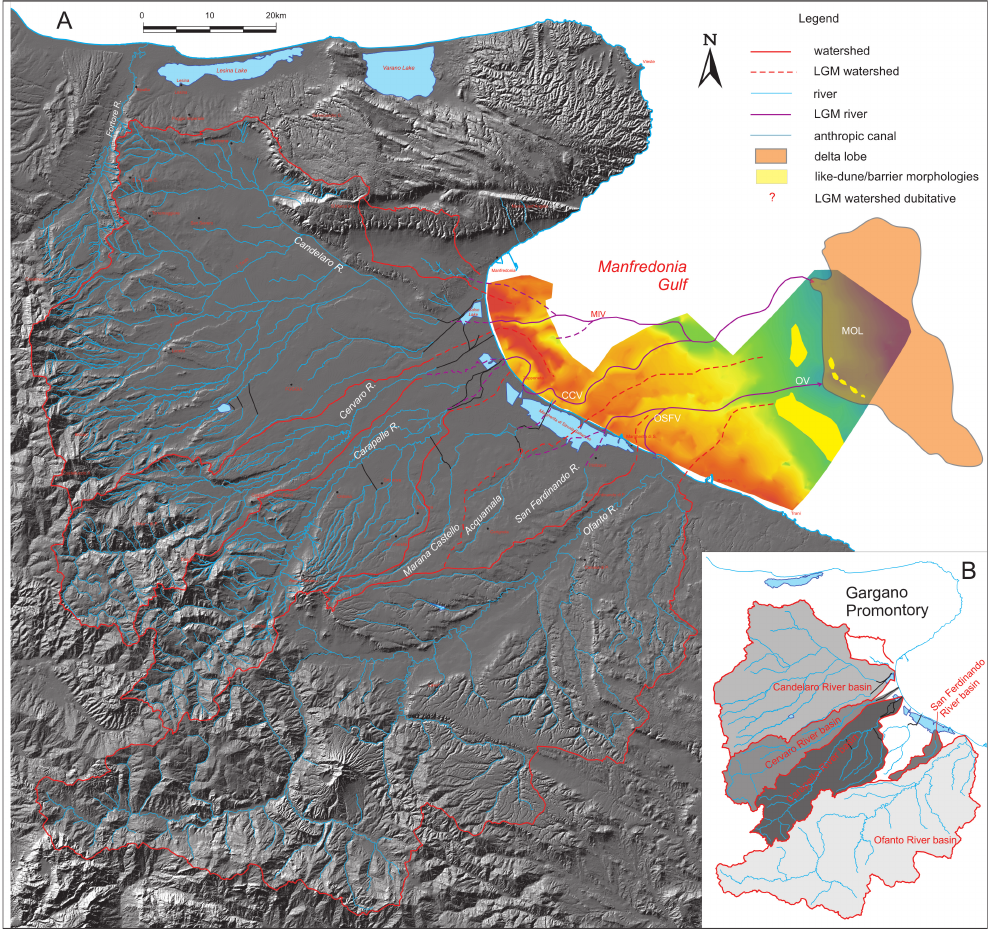
Figure 11. ( A ): Digital Elevation Model (DEM) of the study area and its surroundings. The inland DEM shows the present catchments of the main rivers draining the Tavoliere di Puglia Plain and the Gargano Promontory. The ES1 is shown o ff shore. On the ES1, the Manfredonia–Ofanto lobe (MOL) and the extension of facies 2 bodies modelled into the dune-like / barrier morphology of units A l and B m are shown. The reconstructed drainage network and watersheds are also shown along the